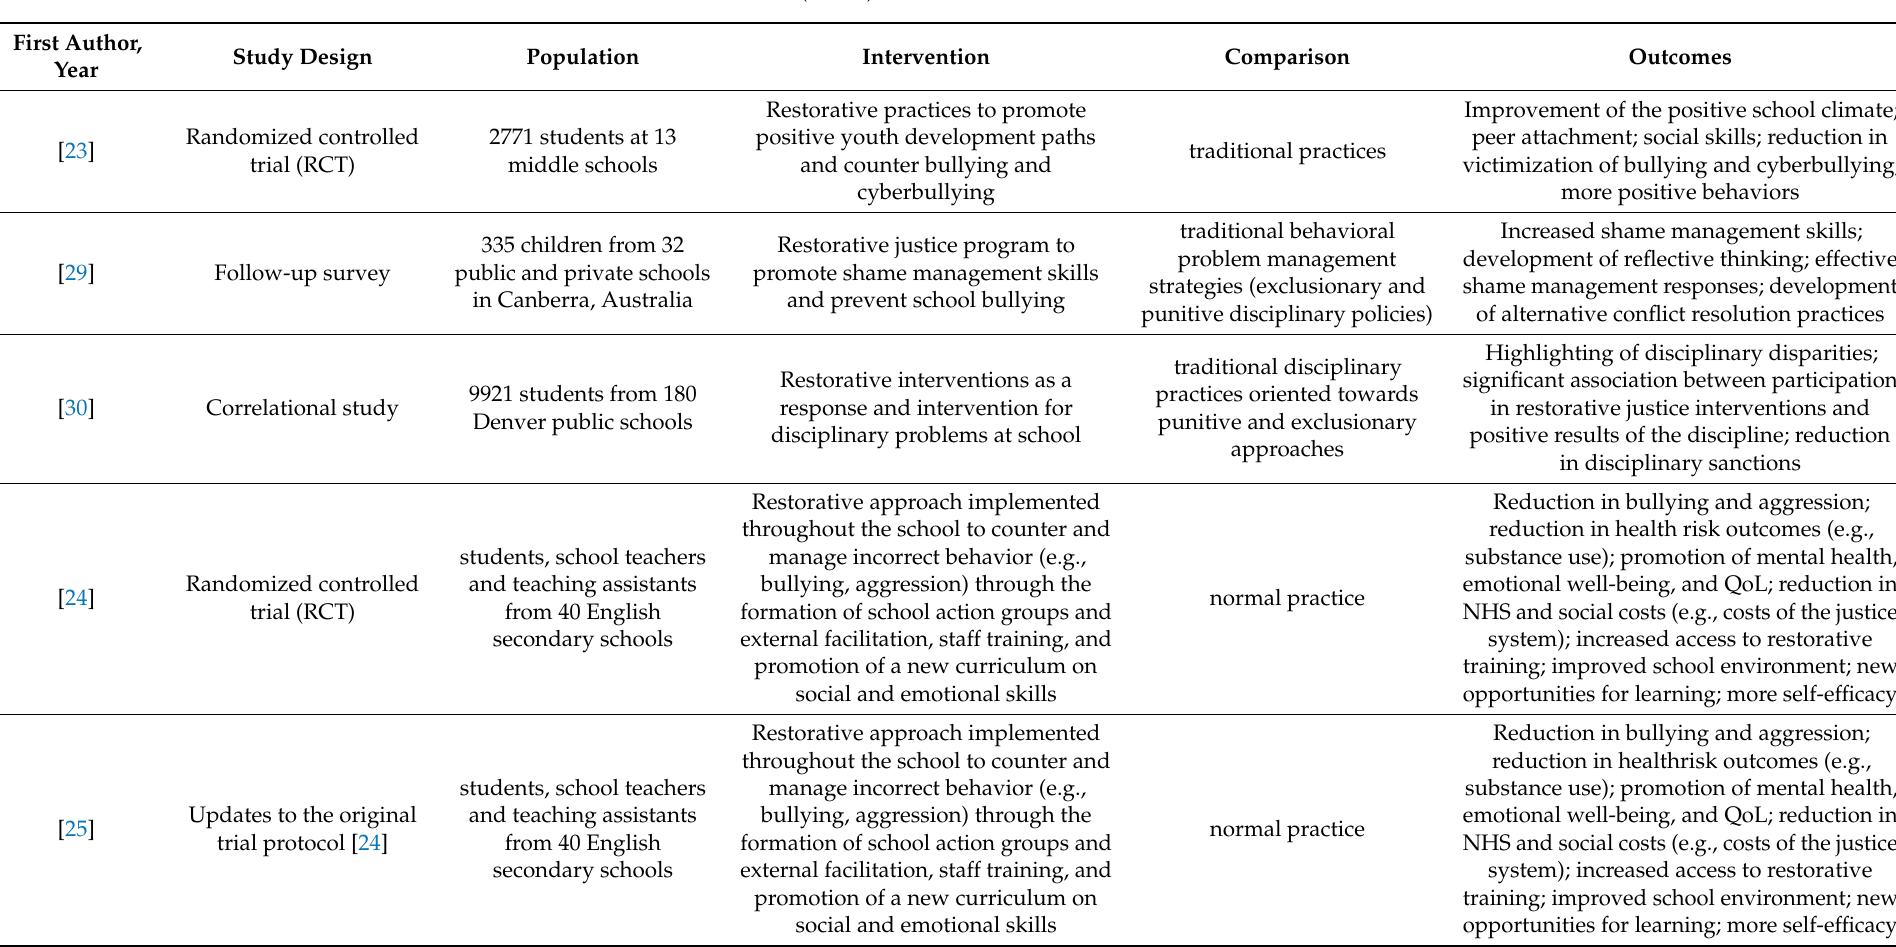
Table A2. Characteristics of the included studies ( n =